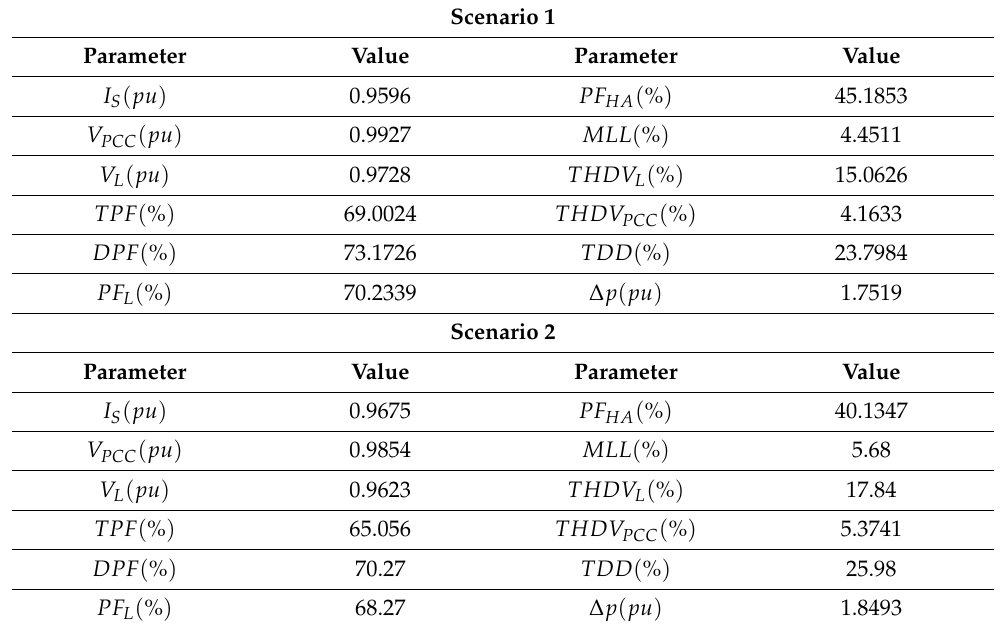
Table 3. The uncompensated system results under two